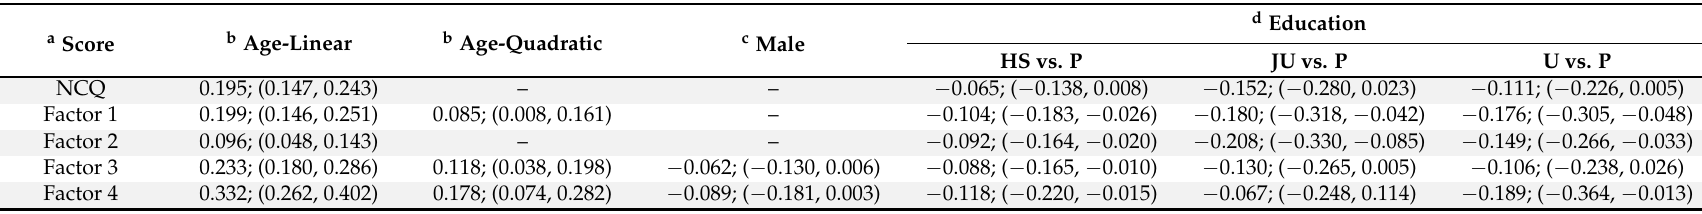
Table 5. Final models chosen for each score, with estimates (and 95% confidence intervals) for the terms in the model; “–” indicates term was not in the final model. Final models were chosen using the All Available (AA) Sample.